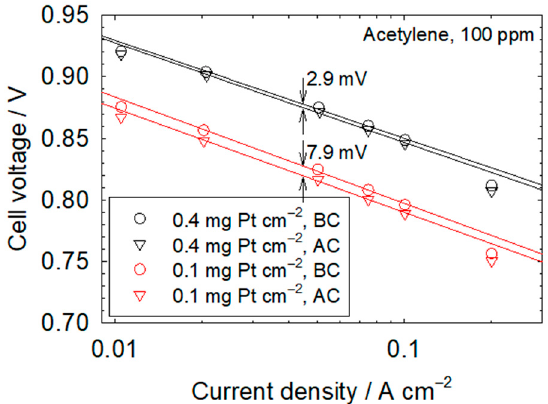
Figure 4. Tafel plots before contamination (BC) and after contamination (AC) with 100 ppm acetylene for 0.1 and 0.4 mg Pt cm –2 catalyst loadings. The change in cell voltage between plots at a current density of 0.0447 A cm –2 , a value located in the middle of the range used to correlate data (0.02 to 0.1 A cm –2 ), ignores the slight change in